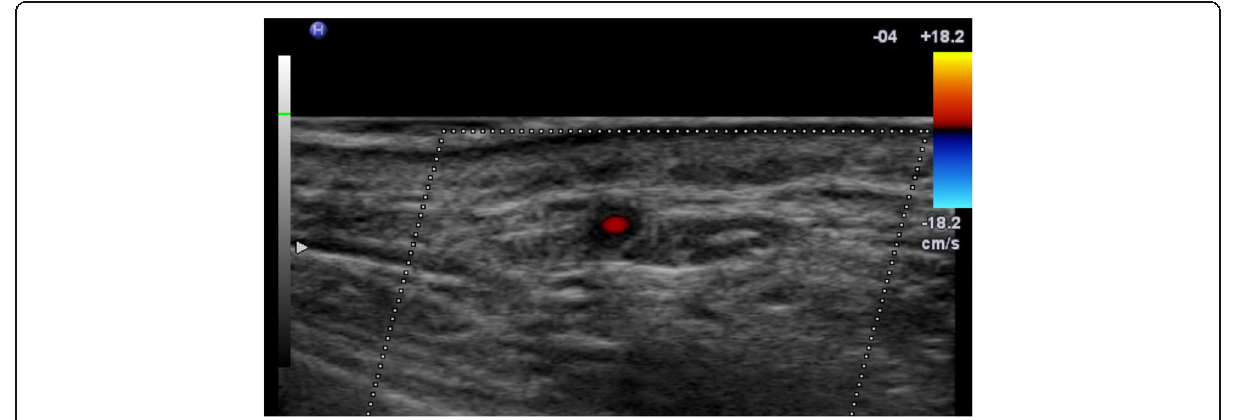
Fig. 1 CDUS of the right temporal artery with a hyporeflective « halo » around the temporal artery in a patient with subsequently a positive temporal artery